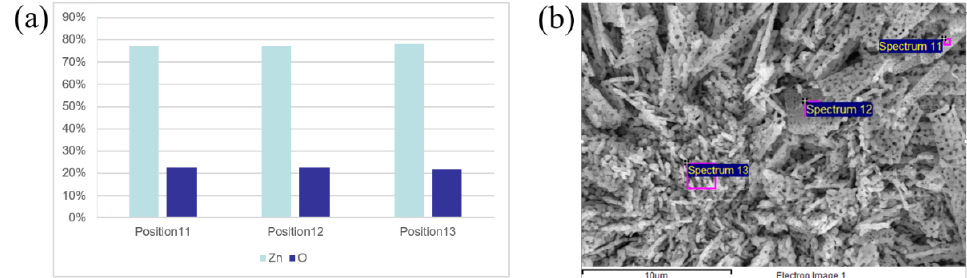
Figure 5. ( a ) The plots of Zn and O elements at different positions ( b ) three different positions of electron image.